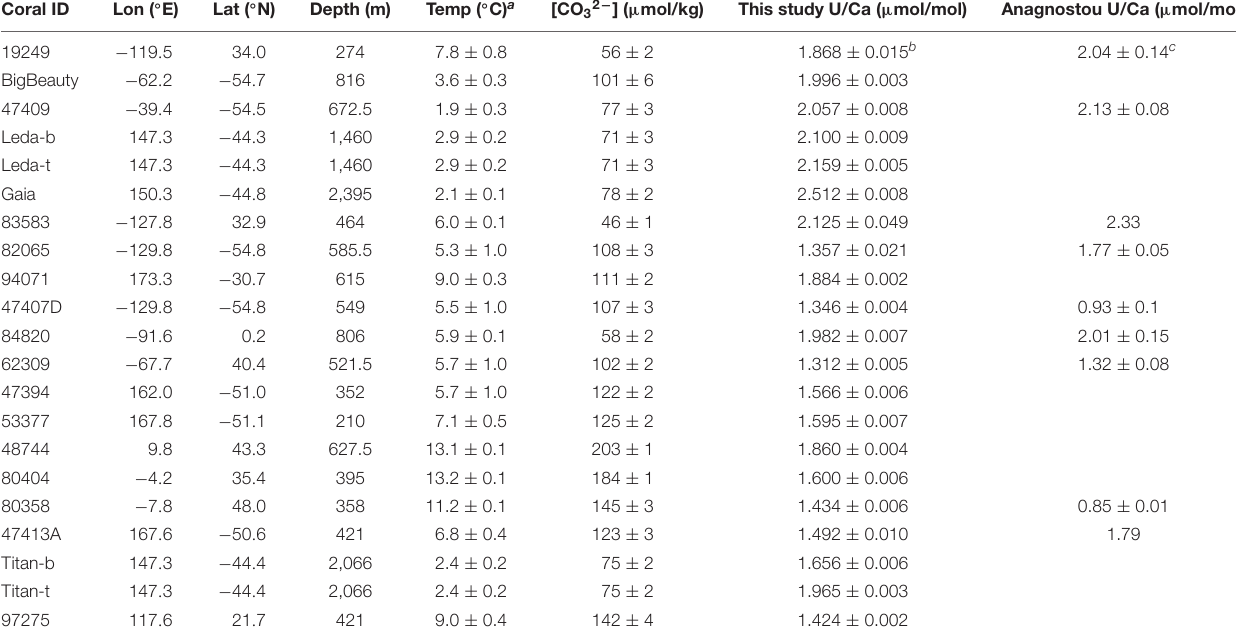
TABLE 1 | Bulk U/Ca of D. dianthus used in this study. Coral ID Lon ( ◦ E) Lat ( ◦ N) Depth (m) Temp ( ◦ C) a [CO 32 − ] ( µ mol/kg) This study U/Ca ( µ mol/mol) Anagnostou U/Ca ( µ